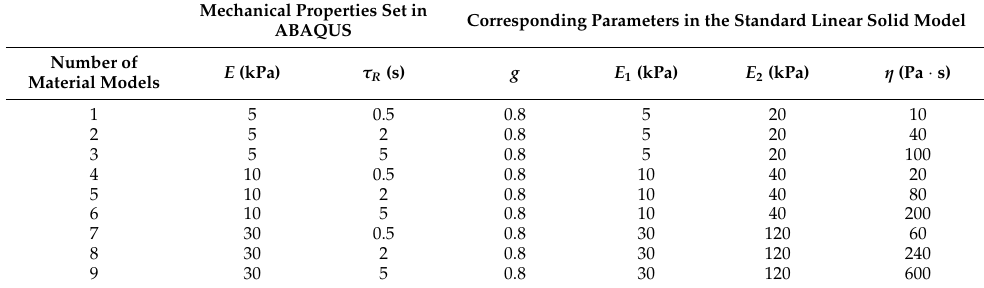
Table 1. The setting of the mechanical properties of the nine material models used in the simulation. Mechanical Properties Set in